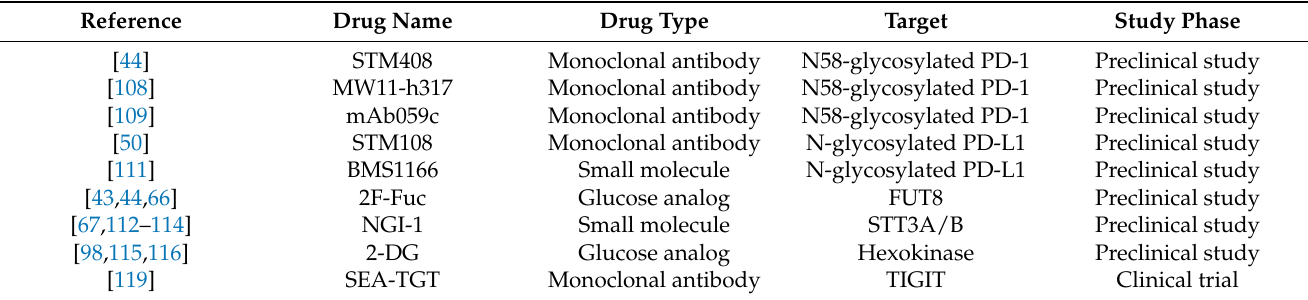
Table 1. Novel drugs in glycosylation-targeted